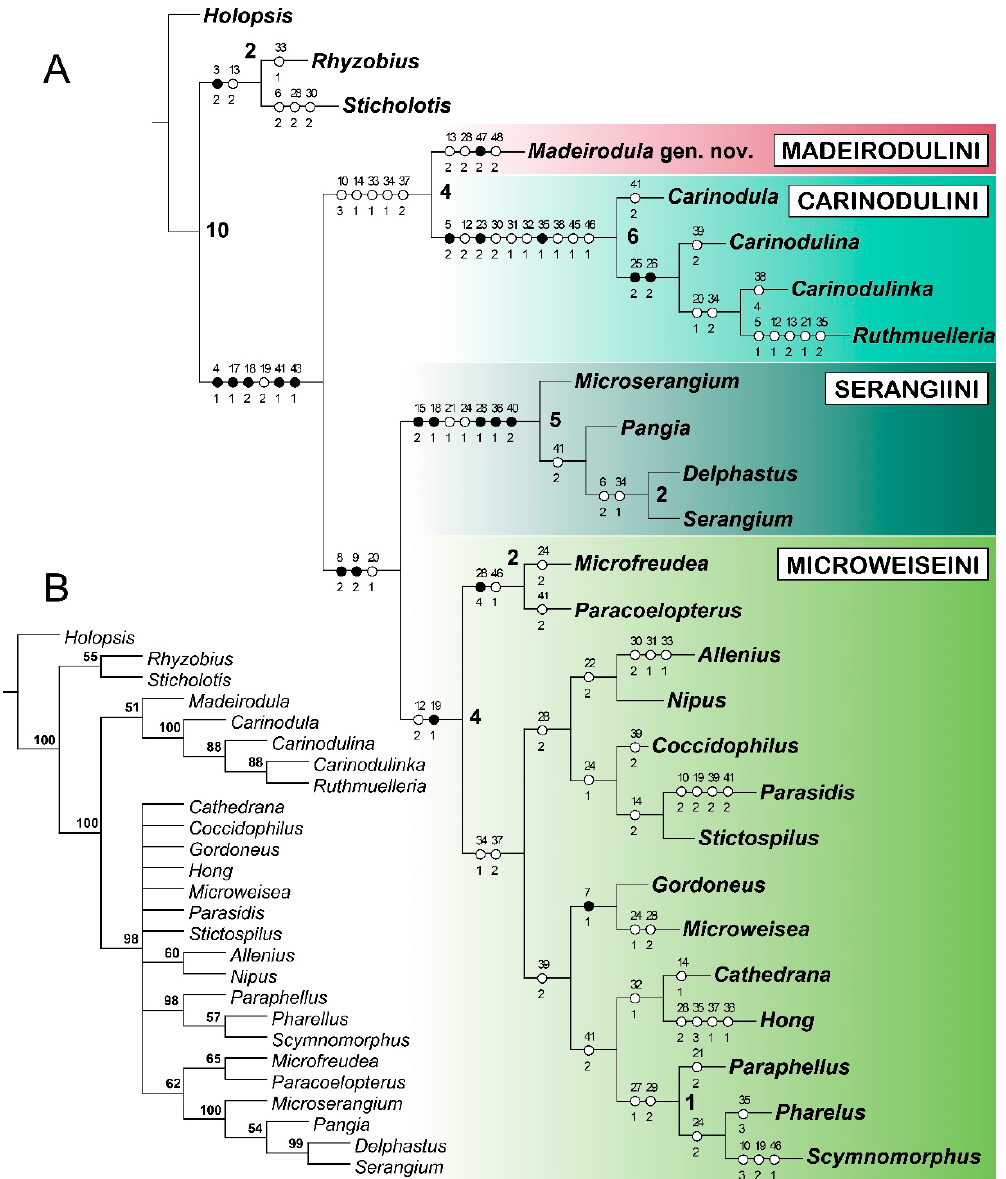
Figure 1. Results of the phylogenetic analyses. ( A ) The single most parsimonious tree from TNT, with character evolution of Microweiseinae; all character states are treated as unordered and equally weighted. Characters were mapped on branches using unambiguous character changes in Winclada (black circles, non-homoplasious changes; white circles, homoplasious changes); numbers above the circles indicate characters, and numbers below circles indicate their states. Numbers at the corresponding nodes showing Bremer support values. ( B ) Consensus tree from the Bayesian analysis, with numbers at the corresponding nodes showing posterior probabilities reported for the corresponding nodes.